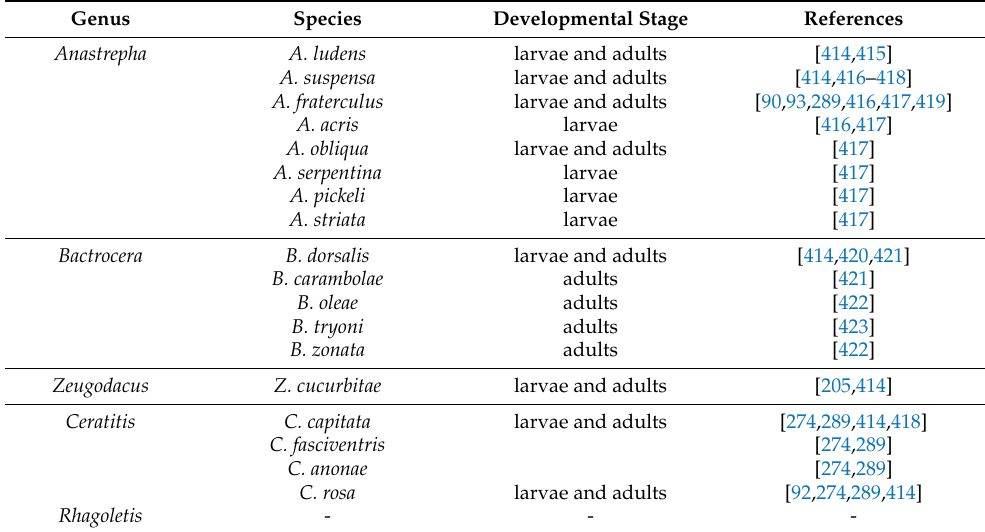
Table 4. List of tephritid species for which CHs have been